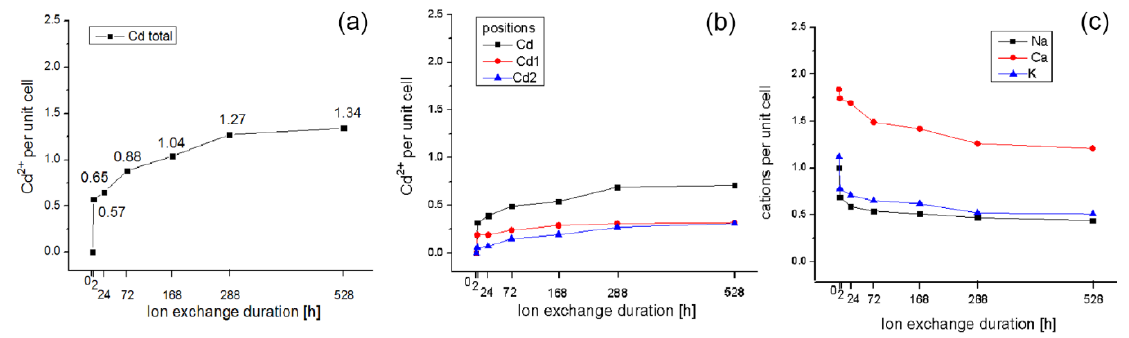
Figure 9. Extent of Cd exchange ( a ), Cd sites ( b ), and outgoing cations ( c ) at RT. Table 7. Number of atoms per unit cell in the cationic positions of initial and Cd-exchanged clinoptilolite (Cpt) at RT. Sample